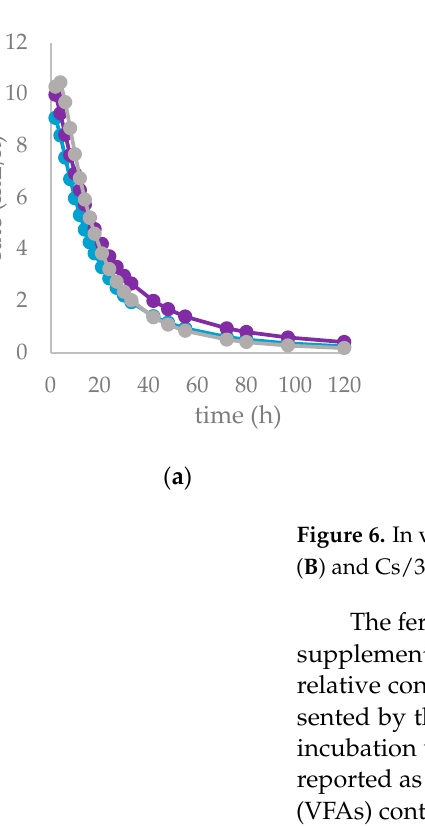
(VFAs) content, expressed as mmol/L (Table 7). Table 6. In vitro gas production and fermentation rate of different C. sativa extracts after 24 h of incubation. OMD: organic matter degradability; CH 4 (mL/g iOM): methane production related to incubate organic matter; CH 4 (mL/d OM): mL of methane production related to degraded OM. Along the row ** p < 0.01 and *** p < 0.001; NS : not significant; MSE: mean square error. both the Cs/1/1 extract and its Cs/3/2 fraction. These results are only partially in line with mg/mL) for 24 h of incubation, found a significant decrease in acetate and A/P with a